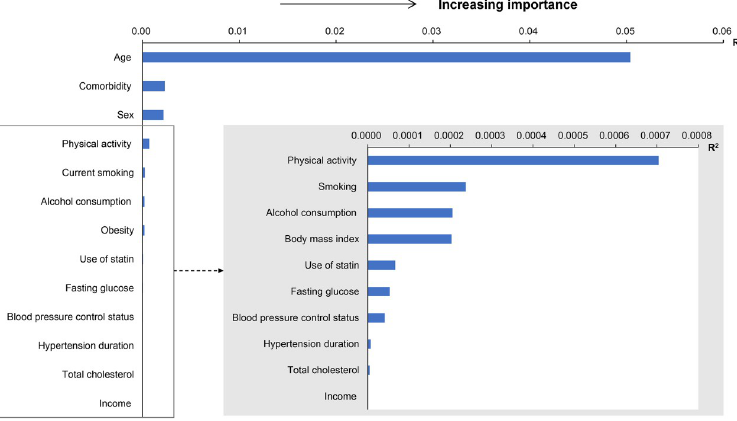
Fig 1. The relative importance of risk factors for the development of dementia among patients with